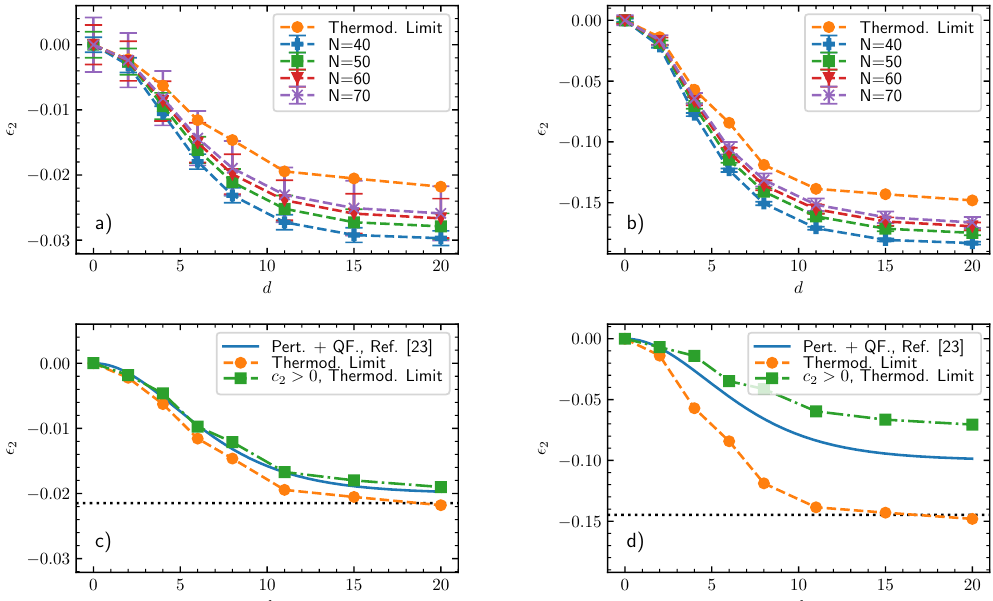
Figure 12: Interaction potential between two impurities induced by the Bose gas for γ = 0.02 in the attractive case, c < 0, with two different strengths a) c 2 = − 0.1. The curves show different values of N listed in the insets. We also give b) c 2 our prediction for the induced interaction potential in the thermodynamic limit. No error bars are shown for this case, since we cannot estimate them reliably, see text. In the lower panels, we display our prediction for the values in the thermodynamic limit (orange dots) and the corresponding result based upon perturbation theory, which includes quantum fluctuations [ 23 ] (solid blue curve). Panels c) and d) are for = − 0.02 and c = − 0.1, respectively. For comparison, we also show the negative c 2 2 > 0 (green squares). The dashed curves are plotted to guide IM-SRG result for c 2 the eye while the dotted lines in c) and d) give the self-energy of a single impurity ( c = 0, c ) − E ( c = 0, c = 0 ) , in the thermodynamic E 2 1 2 2 1 2